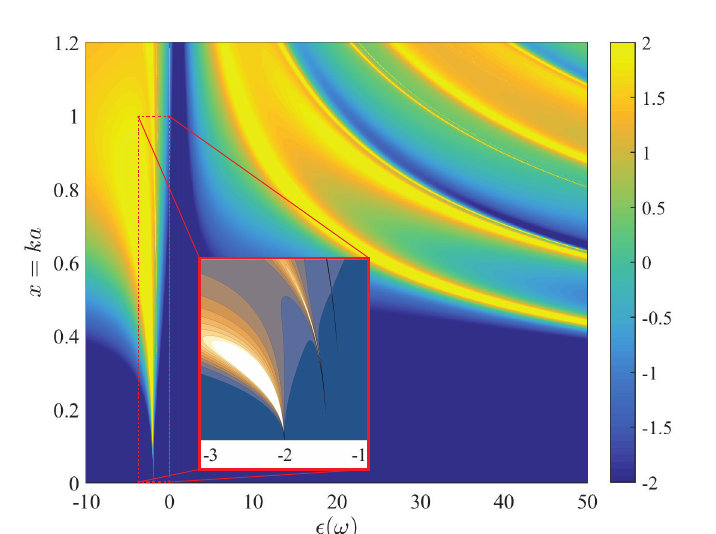
Figure 2. The scattering efficiency of a homogeneous sphere (in logarithmic scale), normalized for better visualization of the results, as a function of the permittivity (lossless case) and the size parameter. The yellow regions correspond to radiation enhancement regions. Note two different regions, one for negative (plasmonic region) and for positive (dielectric) permittivity. The inset figure shows an magnification on the plasmonic region, where the first three electric multipole resonances are visible. (Adapted with permission from [63], IEEE, 2017).